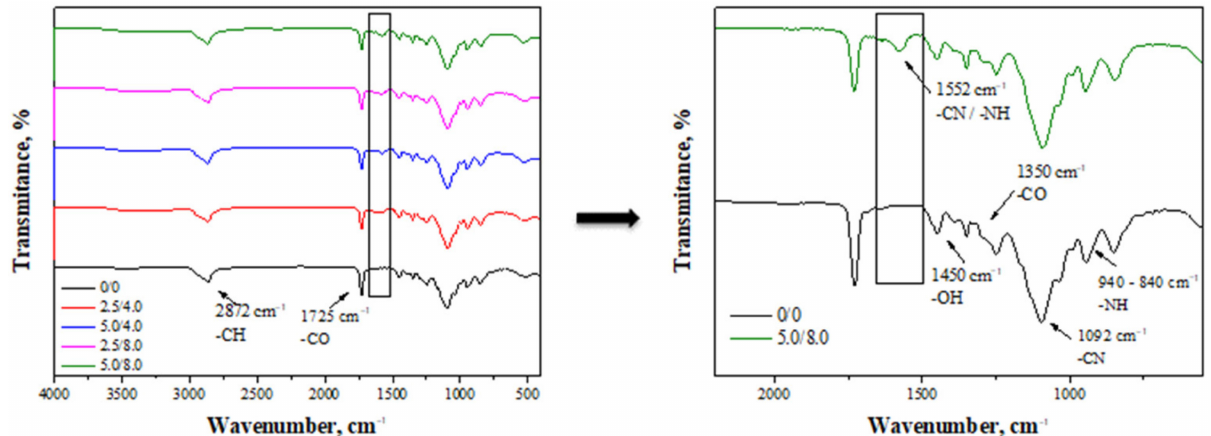
Figure 2. FT-IR spectra of hydrogel materials ( left ) with enlarged range of visible changes observed on the spectra of modified hydrogels ( right